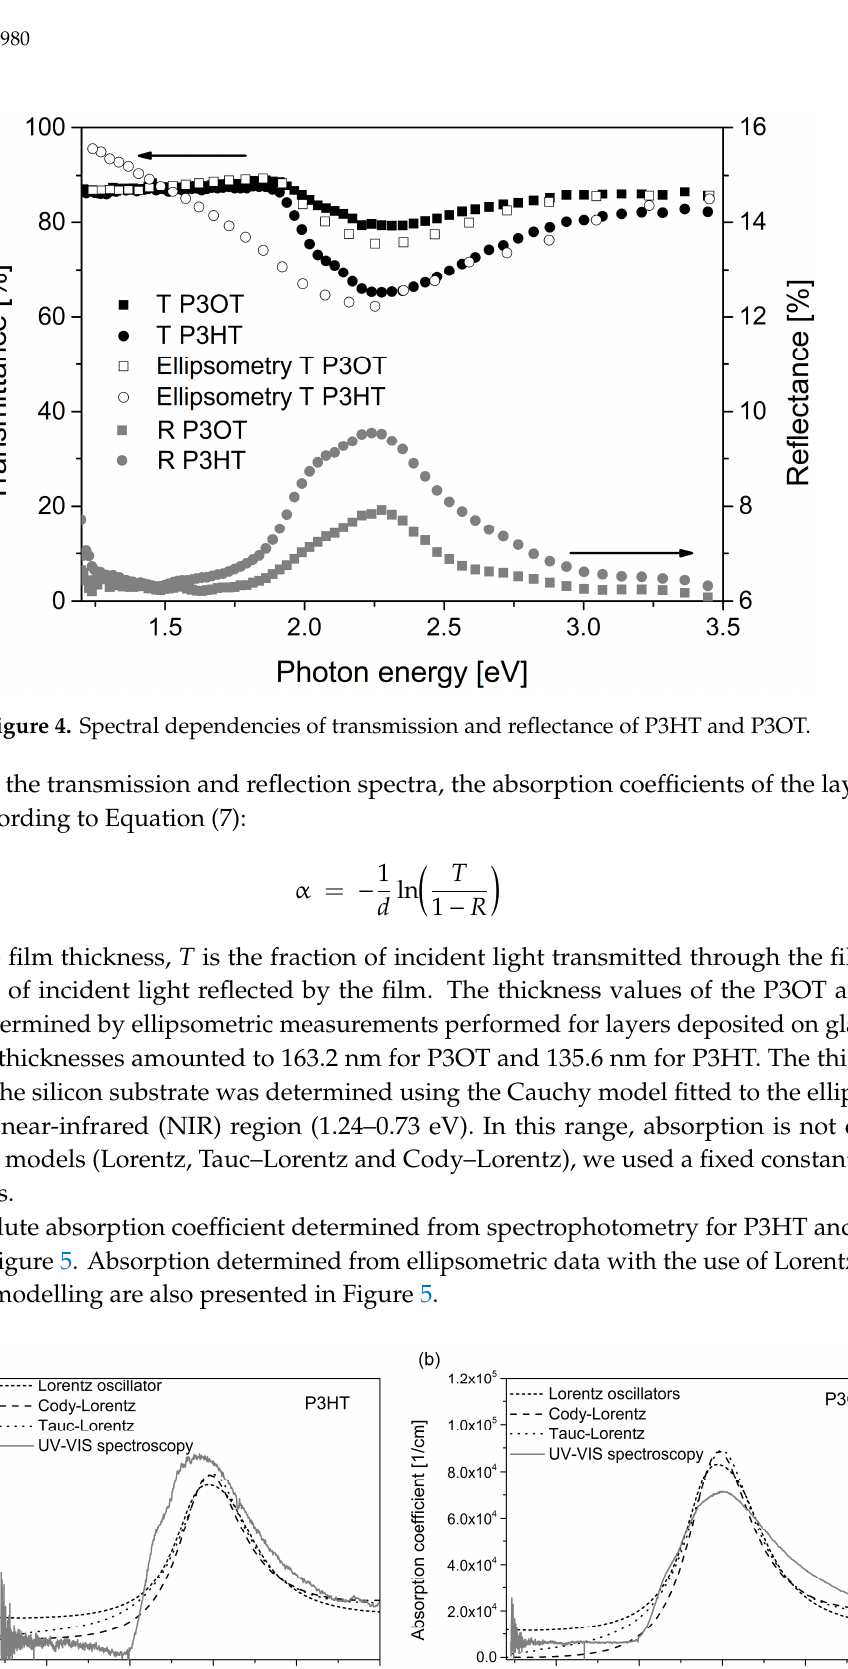
Figure 5. Absolute absorption coefficient determined from spectrophotometry compared with absorption modelled from ellipsometric data ( a ) P3HT, ( b ) P3OT.